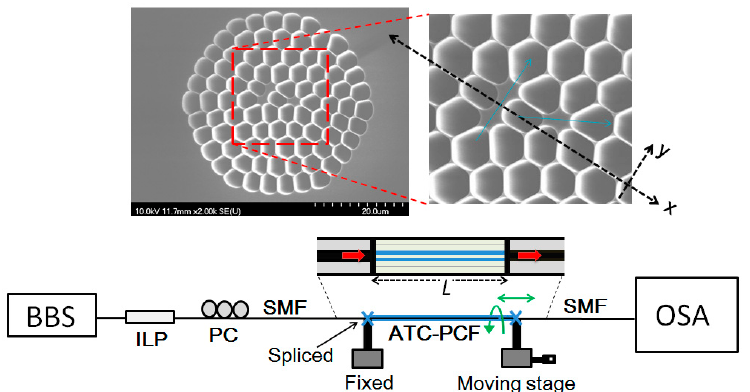
Figure 1. Experimental setup of the fiber MZI based on ATC-PCF. Inset shows the microstructure of ATC-PCF with two independent and birefringent cores. The slow axes of two cores are mutually inclined at an angle of ~70°.